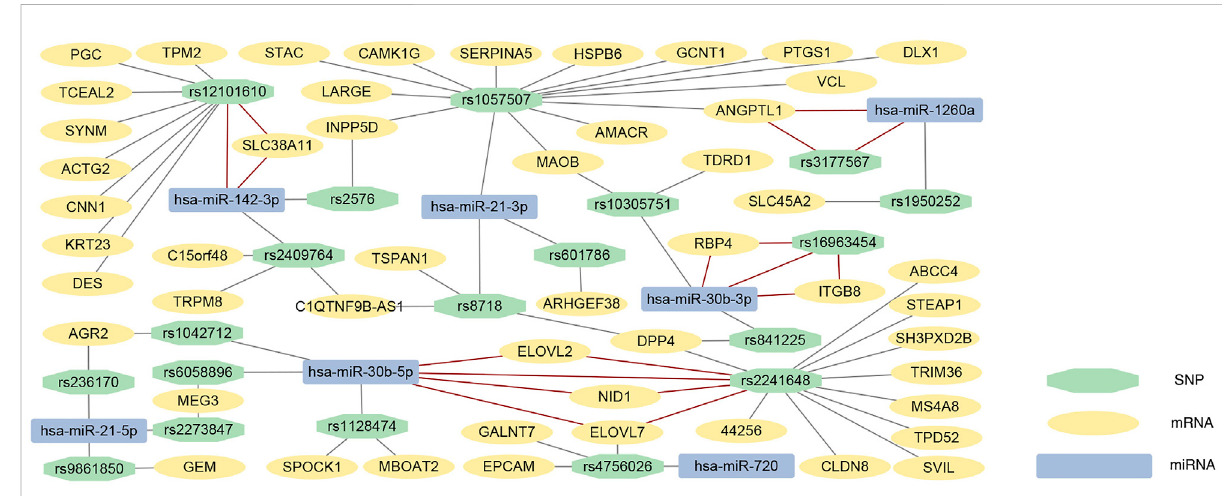
FIGURE 4 mRNA-SNP-miRNAinteractionnetwork.EveryboxrepresentsonemRNA,SNPormiRNA,detailedinthelegend.The7mRNA-SNP-miRNAtrios withpredicted mRNA-miRNApairsareconnectedbyredsolidlines, andothermRNA-SNP-miRNAtrioswereconnectedbythegreysolidlines. SNP, single nucleotide polymorphism; miRNA,